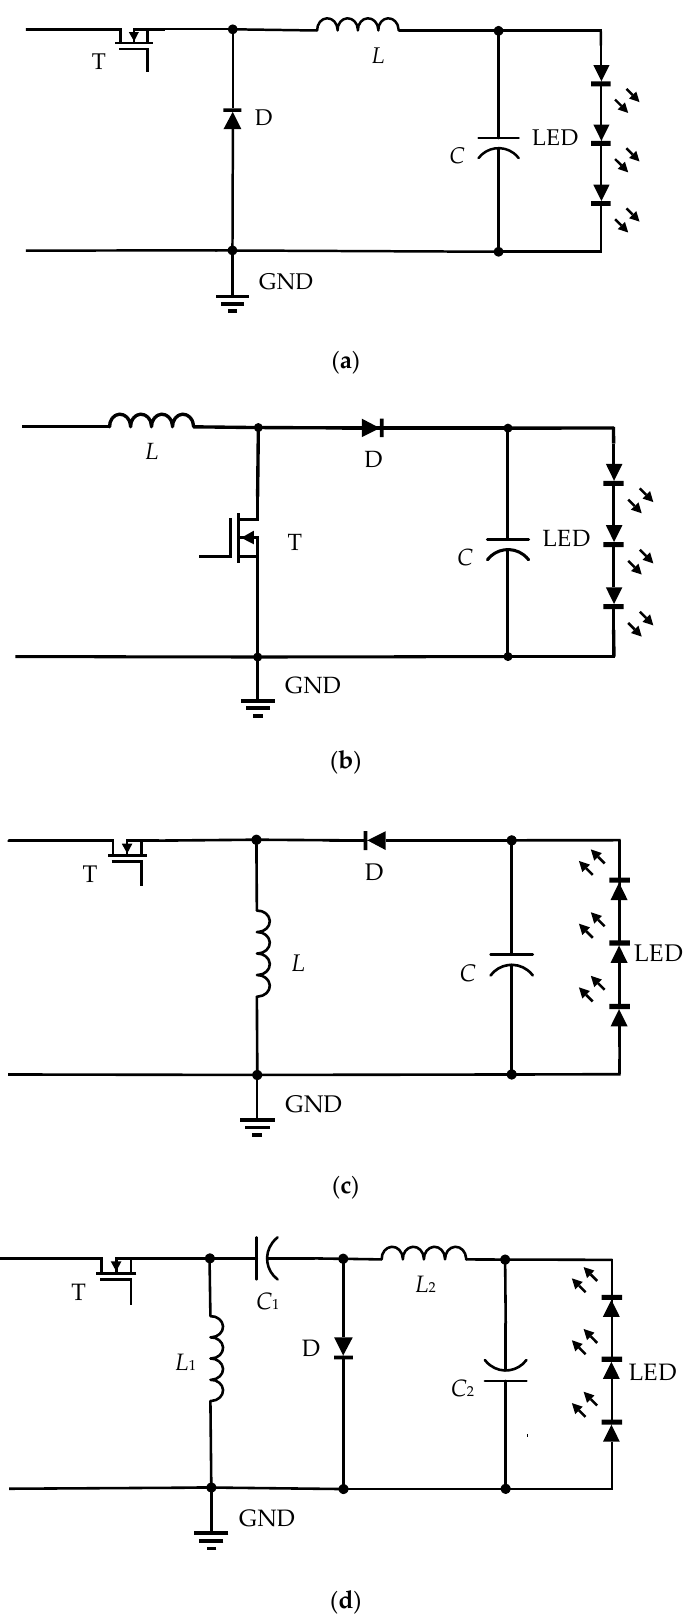
Figure 1. Conventional method for LED connection. ( a ) Basic LED buck converter; ( b ) Basic LED boost converter; ( c ) Basic LED buck–boost converter; ( d ) Basic LED Ć uk converter.